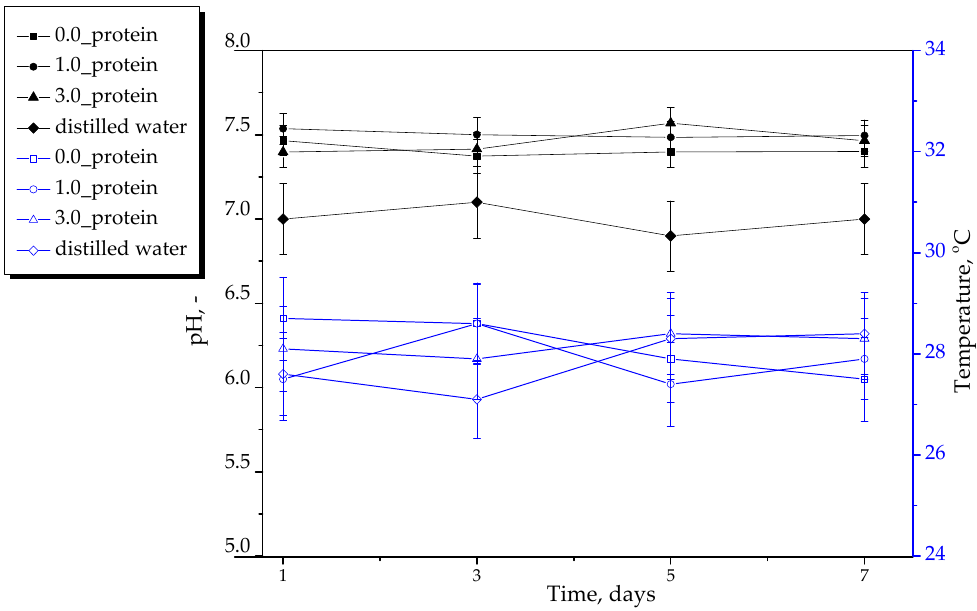
Figure 5. Results of hydrogels’ incubation in distilled water ( n —number of repetitions, n = 3).